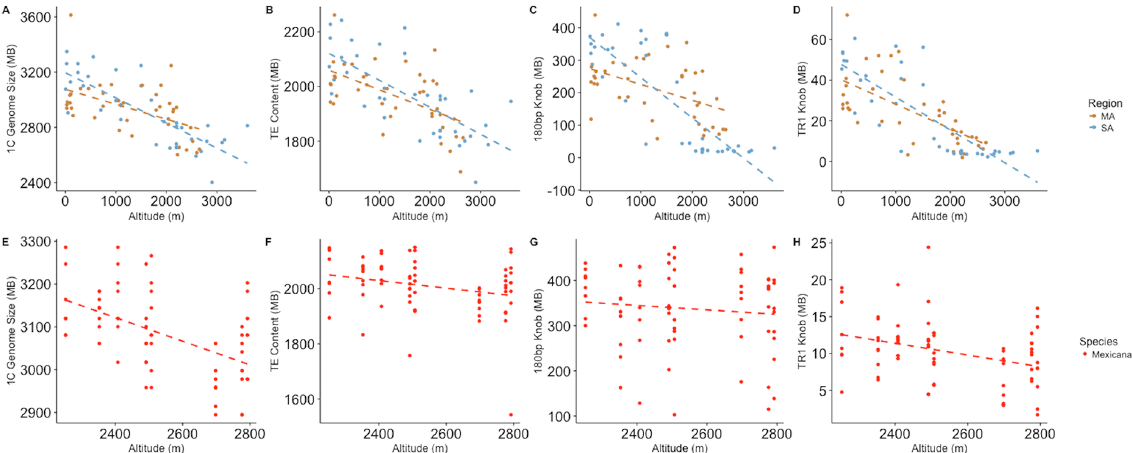
Fig 1. Genome size and repeat content by altitude in Zea taxa. (A-D) Maize landraces from Mesoamerica (MA) or South America (SA). (E-H) Highland teosinte Z. mays ssp. mexicana . Only teosinte populations above 2000m that do not show admixture (see text) are included. (A, E) total genome size, (B,F) total transposable element content, (C,G) 180bp knob repeat content, (D,H) TR1 knob repeat content. Dashed lines represent the best fit linear